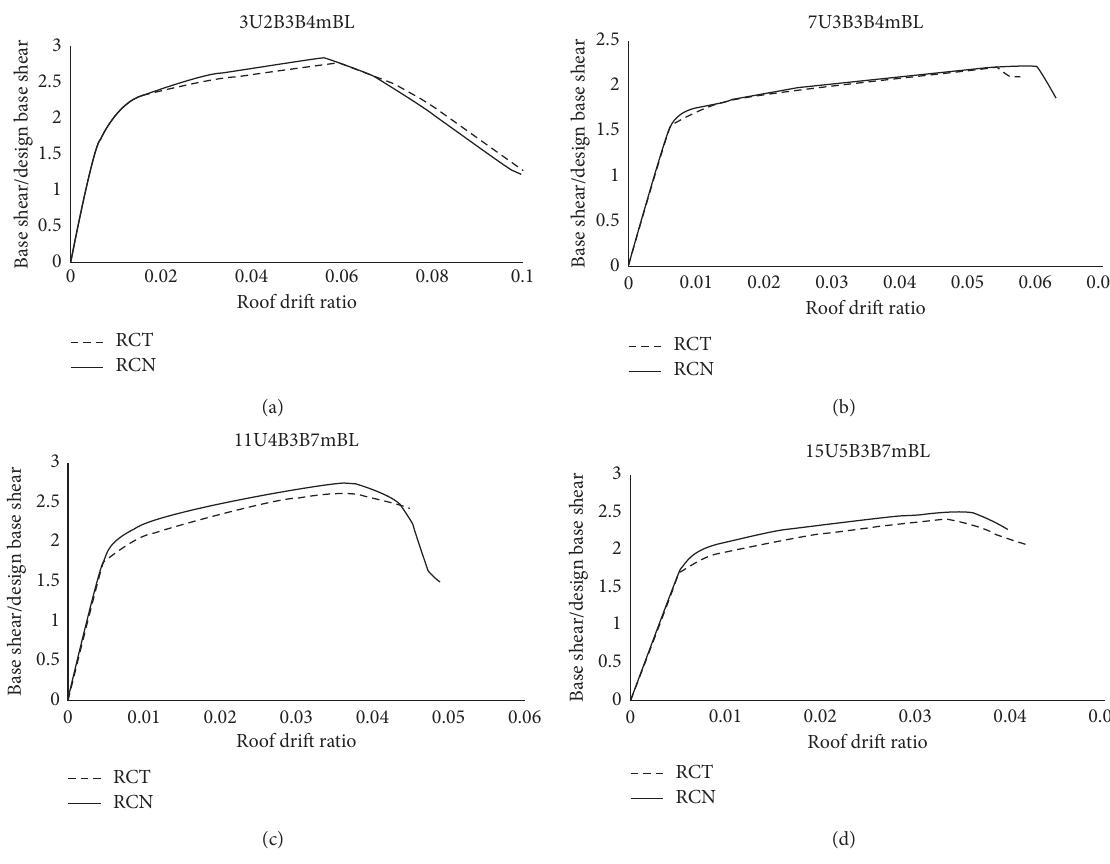
Figure 6: Normalized pushover curves comparison for some of the archetypes as samples for both RCN and RCT models.